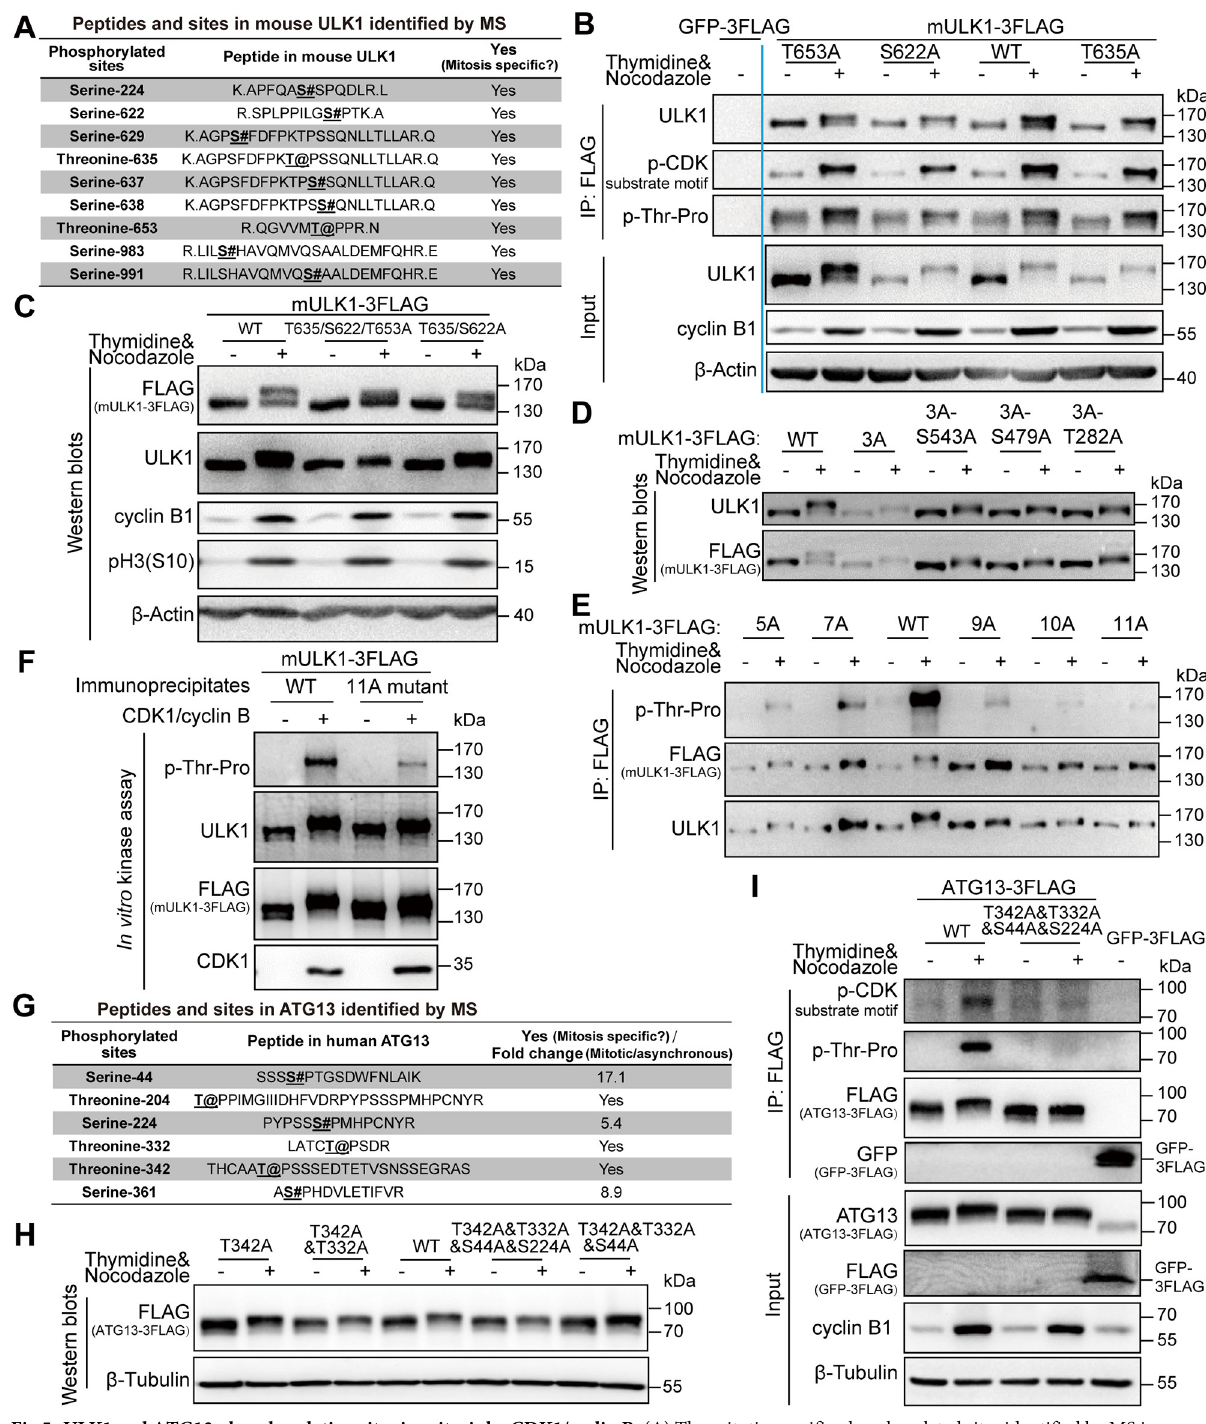
Fig 5. ULK1 and ATG13 phosphorylation sites in mitosis by CDK1/cyclin B. (A) The mitotic-specific phosphorylated sites identified by MS in mitotic mULK1 compared with asynchronous mULK1. (B-C) S622/T635/T653 phosphorylation contributes to ULK1 mobility shift in mitosis. The 293T cells overexpressing FLAG-tagged mULK1-S622/T635/T653 mutants were synchronized with single-thymidine and nocodazole. Then immunoprecipitation for single mutant with FLAG antibody (B) or western blot analysis for double and triple mutant (C) was performed. (D-E) More sites contribute to ULK1 band shift. Based on triple 3A mutant, the other 8 Ser/Thr sites were mutated into Ala. The 293T cells expressing various mutants were synchronized into mitosis with thymidine and nocodazole for immunoprecipitation by FLAG antibody and western blot analysis. (F) ULK1-11A mutant was not upshifted or phosphorylated by CDK1/cyclin B kinase complex in vitro. The ULK1-11A mutant immunoprecipitates from